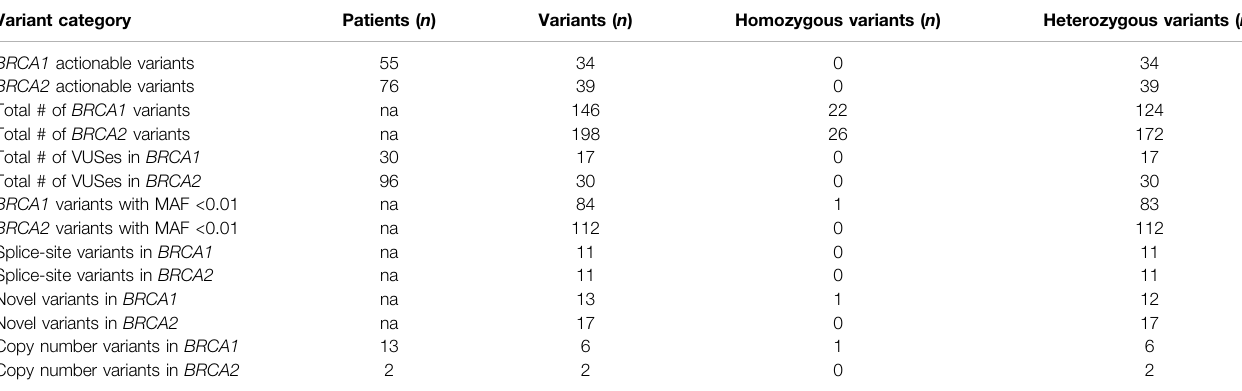
TABLE 4 | Summary of variants detected during comprehensive screening of 1,429 patients. Variant